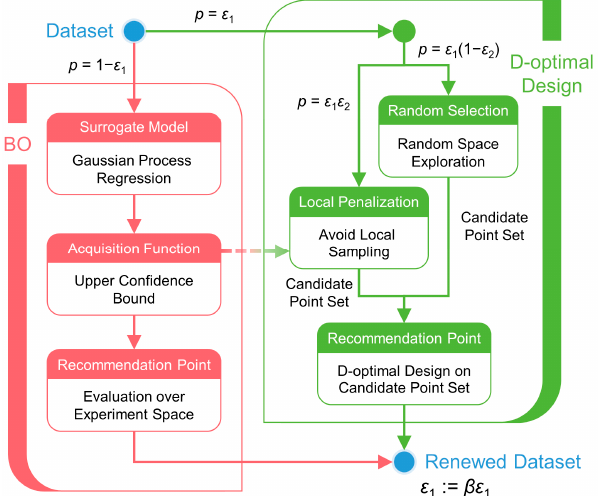
Figure 1. Diagram of BODO framework. Algorithm 3. The pseudocode of BODO. Input: Dataset 𝒟 (cid:2868) ={(𝒙 (cid:3036) ,𝑦 (cid:3036) )} (cid:3036)(cid:2880)(cid:2869)(cid:3041) , 𝜀 (cid:2869) , 𝜀 (cid:2870) , 𝛽 , Candidate point set size 𝑛 (cid:3030) for 𝑡 =1 to 𝑇 do